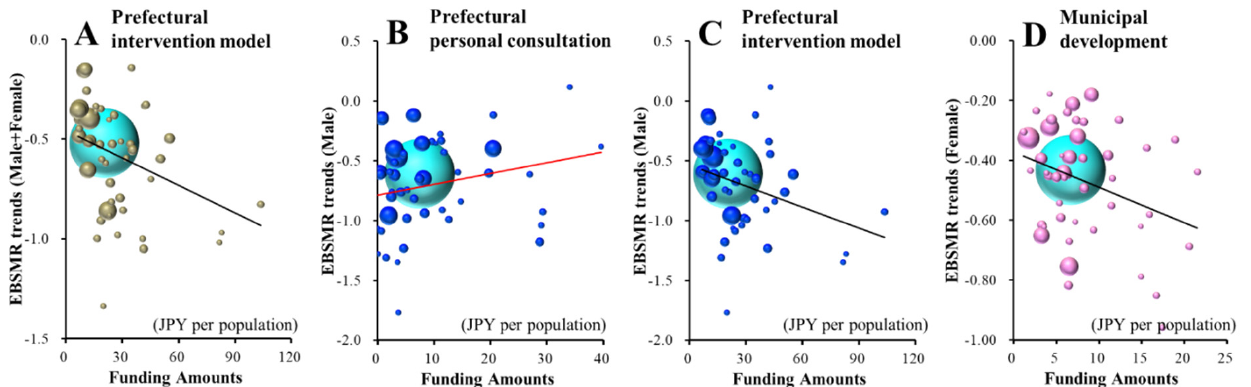
Figure 2. Effects of the amount of funding provided to sub-divisions of EFECBSC on EBSMR trends of Male+Female ( A ), male ( B , C ) and female ( D ) suicide mortalities caused by health-related motives were analysed by forward multiple regression analysis. Ordinates indicate EBSMR trends of suicide mortality caused by health-related motives between 2009 and 2018, and abscissas indicate the amount of funding provided to EFECBSC sub-divisions (JPY per population). Light blue, grey, blue and red spheres indicate national, Male+Female, male and female EBSMR trends and population sizes, respectively. Black and red lines indicate the regression lines of significantly positive (decreases suicide mortality) and negative (increases suicide mortality) factors, respectively. Male+Female EBSMR trends of suicide mortality caused by health-related motives = − 0.0046 × (prefectural intervention model programme) − 0.455. Male EBSMR trends of suicide caused by health-related motives = − 0.0067 × (prefectural intervention model programme) + 0.0113 × (prefectural personal consultation support programme) − 0.624. Female EBSMR trends of suicide caused by health-related motives = − 0.0118 × (municipal development programme of leaders/listeners) − 0.372.